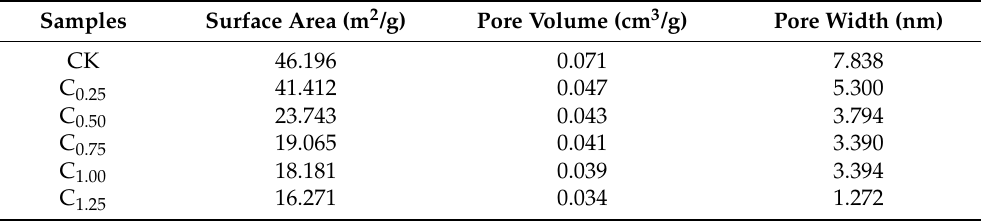
The surface area, pore volume, and pore width of different types of cystamine-modified